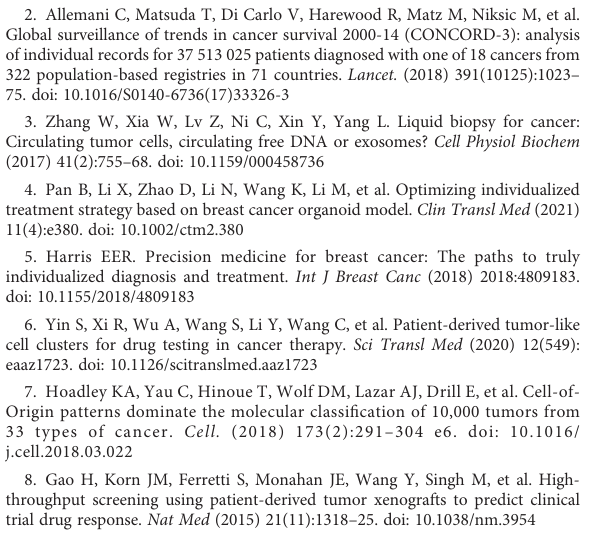
SUPPLEMENTARY TABLE 4 The detailed data of changes in the number of tumor cells before and after drug dosing in case